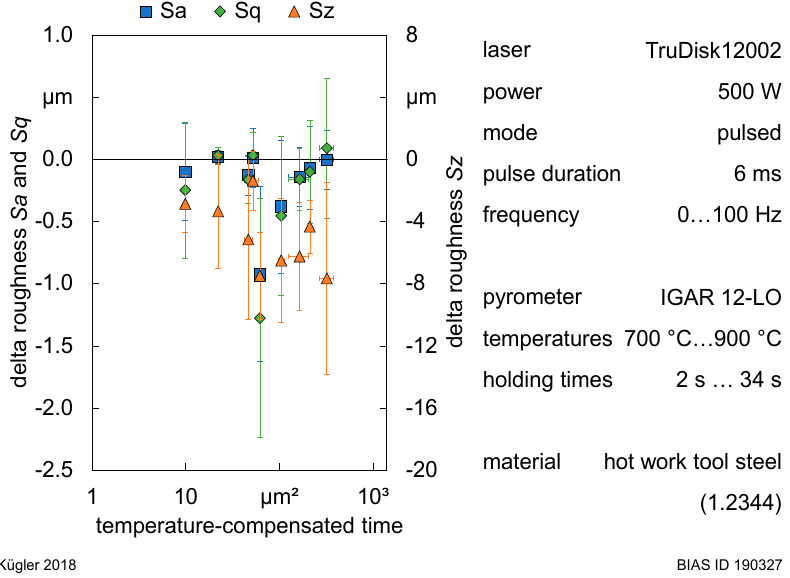
Figure 7. Roughness values Sa , Sq , and Sz of laser-heated 1.2344 sheets.